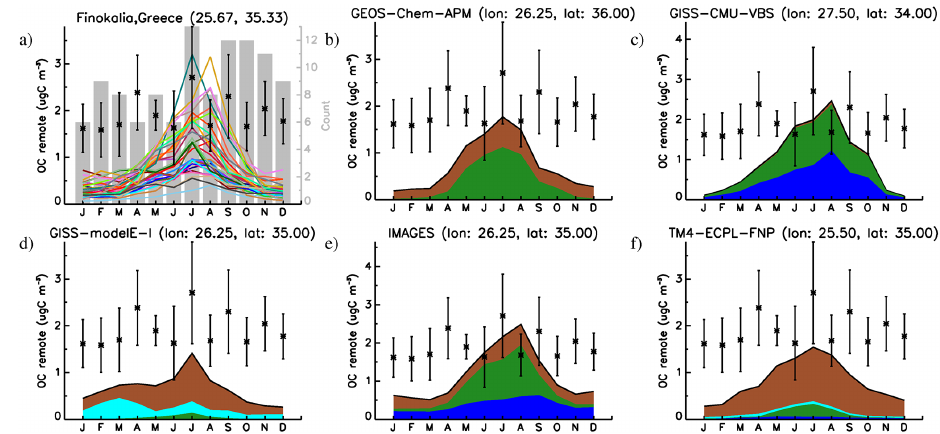
Figure 18. OC seasonality as calculated by all models (a) and chemical composition in GEOS-Chem-APM (b) , GISS-CMU-VBS (c) , GISS- modelE-I (d) , IMAGES (e) and TM4-ECPL-FNP (f) for Finokalia, Greece (remote, years 2004–2007). The coordinates in panel (a) show the location of the station, while those in (b–f) show the center of the grid box of the corresponding model. (a) is similar with those presented in Figs. 16 and 17; for the chemical composition in (b–f) , brown is tPOC, green is trSOC, cyan is mPOC, blue is ntrSOC (aged tPOC for GISS-CMU-VBS, OA formed via multiphase chemistry for all other cases), and orange is MSA. The chemical composition of the remaining models that have submitted at least both tPOC and trSOC data are presented in the Supplement. Note the different scales on the y axes.